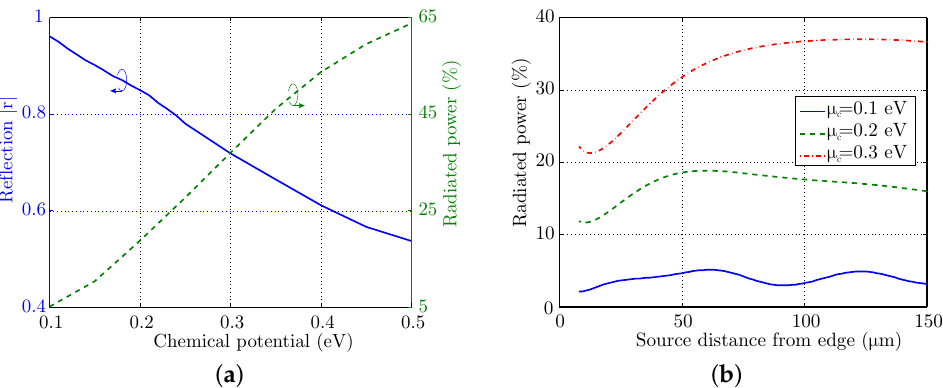
Figure 5. ( a ) Surface wave reflection coefficient and power flow to free-space for graphene with different chemical potentials. ( b ) Power flow to free-space versus surface wave source distance from graphene